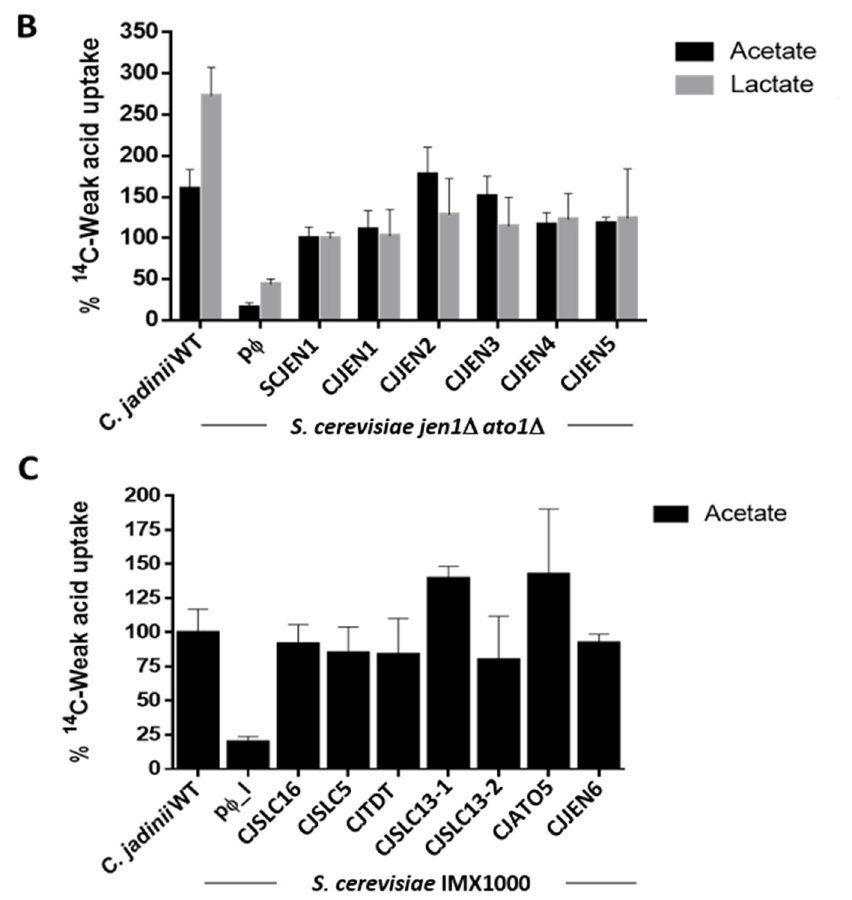
Figure 3. Transport of radiolabeled carboxylates in C. jadinii DSM2361 strain ( A – C ), S. cerevisiae jen1 Δ ato1 Δ ( A , B ), and IMX1000 ( C ) cells expressing the C. jadinii CjATO1-5, CjJEN1-6, CjSLC16, CjSLC5, CjTDT, CjSLC13-1, and CjSLC13-2 proteins, as well as an empty vector (p ɸ ), as negative control. ( A ) Uptake of 1 mM of 14 C-acetic acid (pH 6.0), 14 C-lactic acid (pH 5.0), and 14 C-succinic (pH 5.0) acid. For acetic and lactic acid uptake, a value of 100% (C+) corresponds to the uptake in S. cerevisiae cells transformed with the plasmid p416GPD-expressing genes encoding the native transporters ATO1 and JEN1 , respectively. For succinic acid, a value of 100% (C+) corresponds to isogenic cells expressing the Candida albicans JEN2 transporter cloned in the p416GPD plasmid. ( B ) Uptake of 1 mM 14 C-acetic acid (pH 6.0) and 1 mM 14 C- lactic acid (pH 5.0). A value of 100% corresponds to the uptake of acetic and lactic acid displayed by cells expressing the JEN1 transporter. ( C ) Uptake of 1 mM of 14 C-acetic acid (pH 6.0). A value 100% corresponds to the uptake of acetic acid by C. jadinii DSM 2361 cells. Cells were grown on YNB Glucose, washed, and incubated on YNB containing the respective carbon source (see materials and methods) used in the uptake assay for 6 h (acetate 0.5%, pH 6.0) or 5 h (lactate 0.5%, pH 5.0; succinate 1%, pH